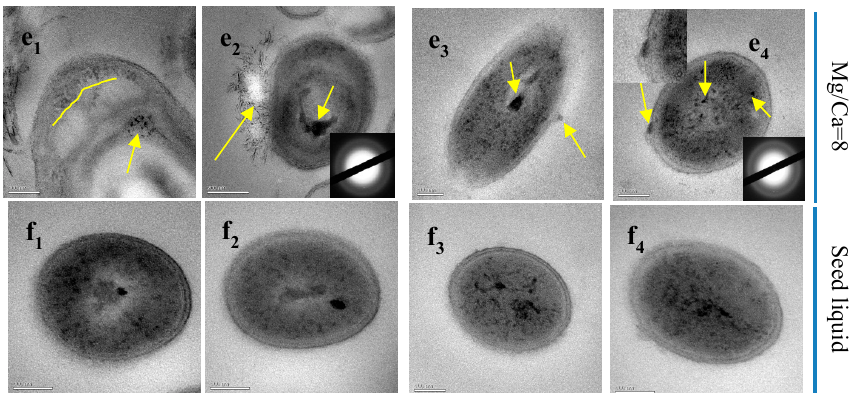
Figure 8. HRTEM and SAED analyses of S. epidermidis Y2 bacterial super-thin slices. ( a1 – a4 ) Mg/Ca ratio of 0; ( b1 , b2 ) Mg/Ca ratio of 2 in the MgSO 4 medium; ( c1 , c2 ) Mg/Ca ratio of 4 in the MgSO 4 medium; ( d1 , d2 ) Mg/Ca ratio of 6 in the MgSO 4 medium; ( e1 , e2 ) Mg/Ca ratio of 8 in the MgSO 4 medium; ( b3 , b4 ) Mg/Ca ratio of 2 in the MgCl 2 medium; ( c3 , c4 ) Mg/Ca ratio of 4 in the MgCl 2 medium; ( d3 , d4 ) Mg/Ca ratio of 6 in the MgCl 2 medium; ( e3 , e4 ) Mg/Ca ratio of 8 in the MgCl 2 medium; ( f1 – f4 ) Seed liquid.